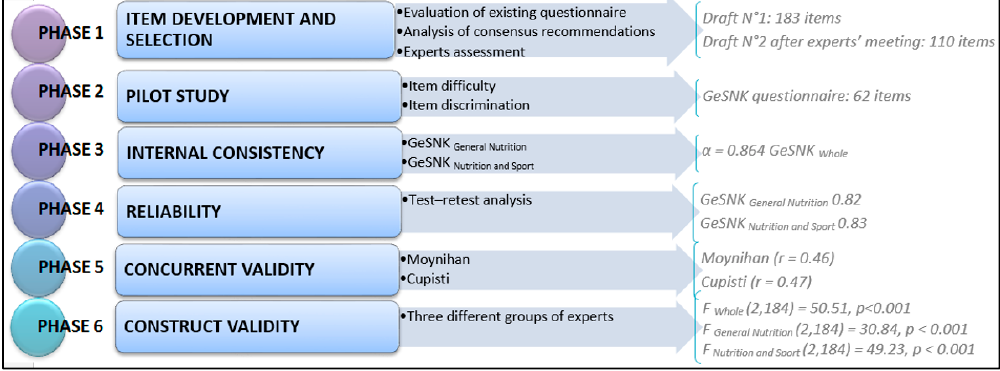
Figure 1. Flow chart of the development and validation of the general and sport nutrition knowledge (GeSNK) questionnaire. (GeSNK)